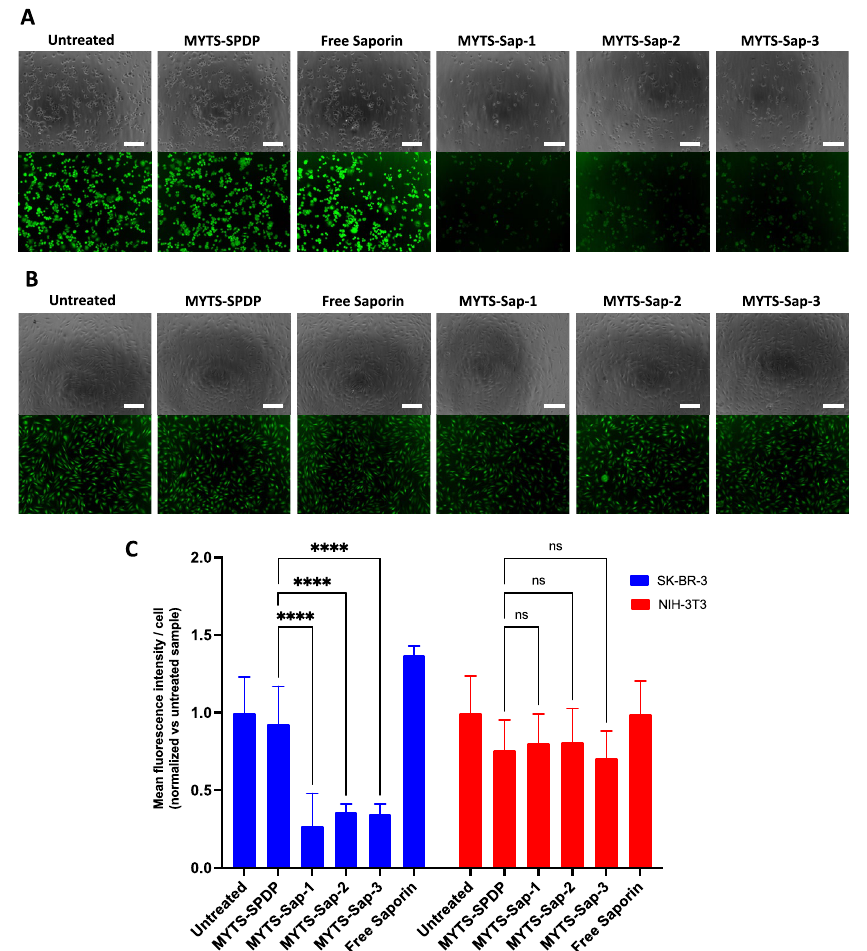
Figure 5. Protein synthesis inhibition assay performed on ( A ) SK-BR-3 cells and ( B ) NIH-3T3 cells, following 6 h incubation with MYTS-SPDP, MYTS-Sap-1, MYTS-Sap-2 and MYTS-Sap-3 at concentrations of 50 µg/mL and free Saporin and the equivalent highest concentration found in MYTS-treated samples (approximately 111.1 nM). Scale bars: 200 µm. ( C ) Quantification of fluorescence intensity/cell normalized against the untreated sample. **** p < 0.0001; ns = non-significant vs. MYTS-SPDP.